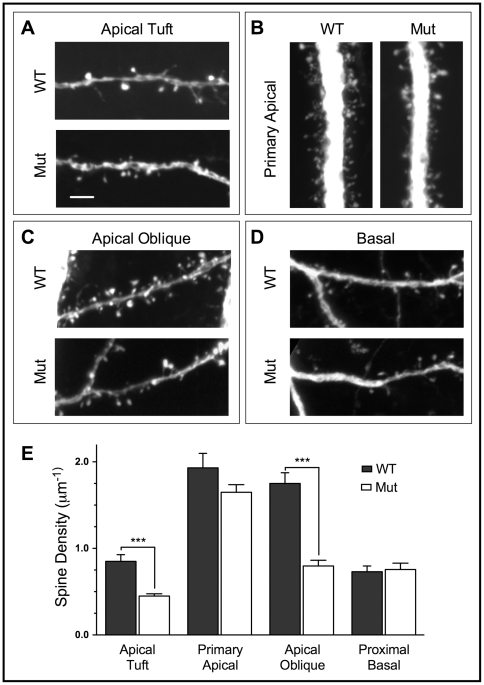
Spine density is variably affected in different dendritic compartments in YFP+ MeCP2J mutant L5 pyramidal neurons.A–D) Spines were quantified in 20–30 µm segments in four dendritic compartments for WT and mutant YFP+ neurons. Scale bar (A) = 5 µm (all images). A) Apical tuft dendrites were sampled <60 µm from the pial surface. B) Primary apical dendrites were imaged between 100–200 µm from the soma. C) Secondary apical dendrites originating in the same region as (B) were sampled beginning at the branch point from the primary apical dendrite. D) Basal dendrite spine counts were initiated following the first dendritic bifurcation. E) Spine density is reduced by 47.4% in the apical tuft and by 54.5% in secondary apical dendrites.